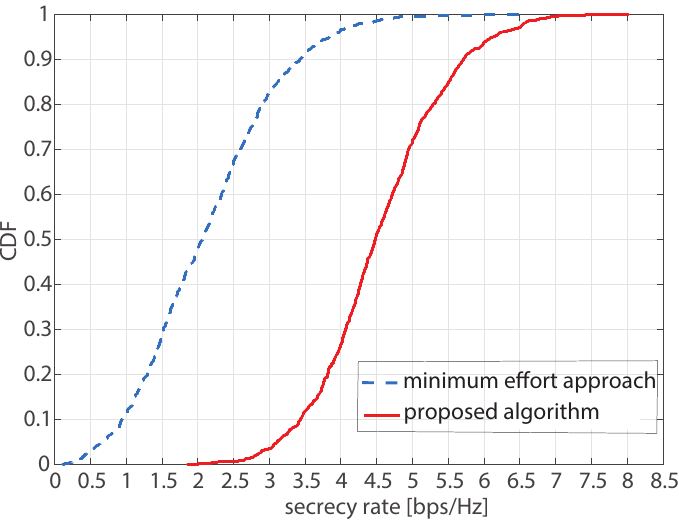
Figure 3. CDF of the lowest total secrecy rate of the proposed algorithm and the minimum effort approach at P t = 1 W and ¯ E = 10